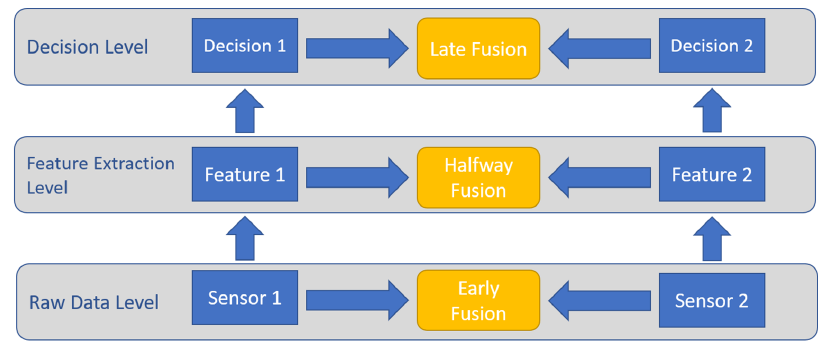
Figure 4. Sensor fusion architecture described in terms of the three different levels. Level one represents early fusion, level two represents halfway fusion, and level three represents late fusion.